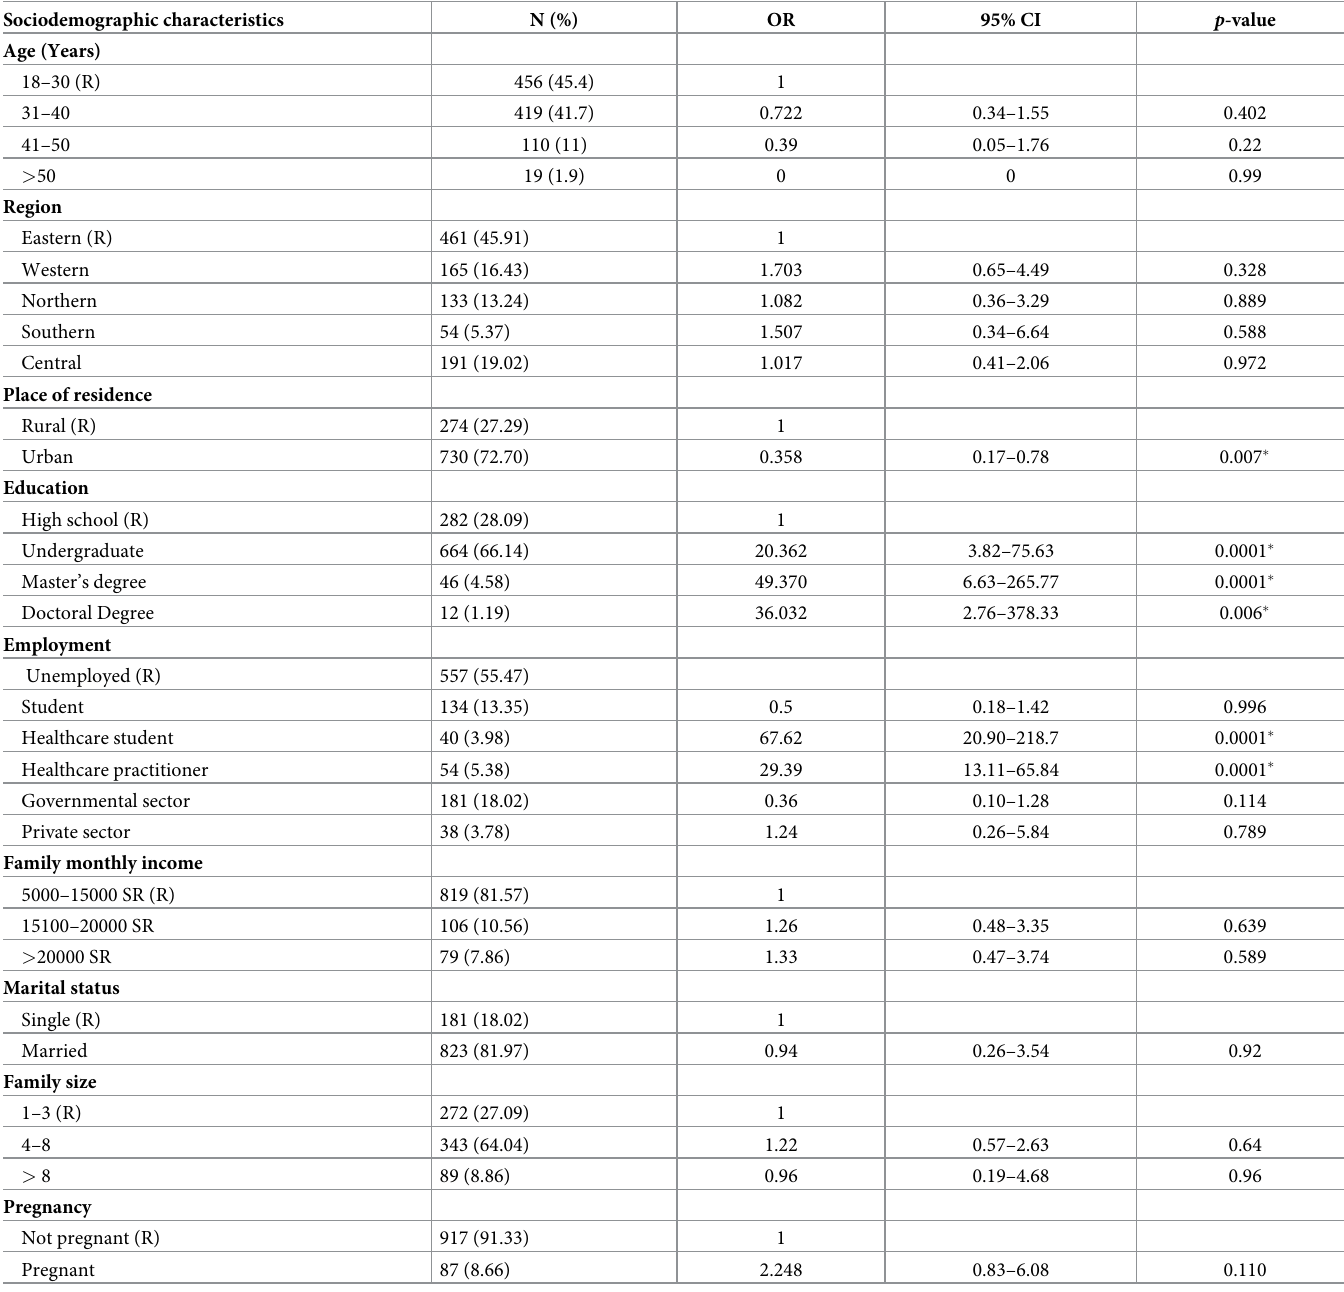
Table 1. Sociodemographic characteristics of survey respondents and their association with knowledge of CMV. Sociodemographic